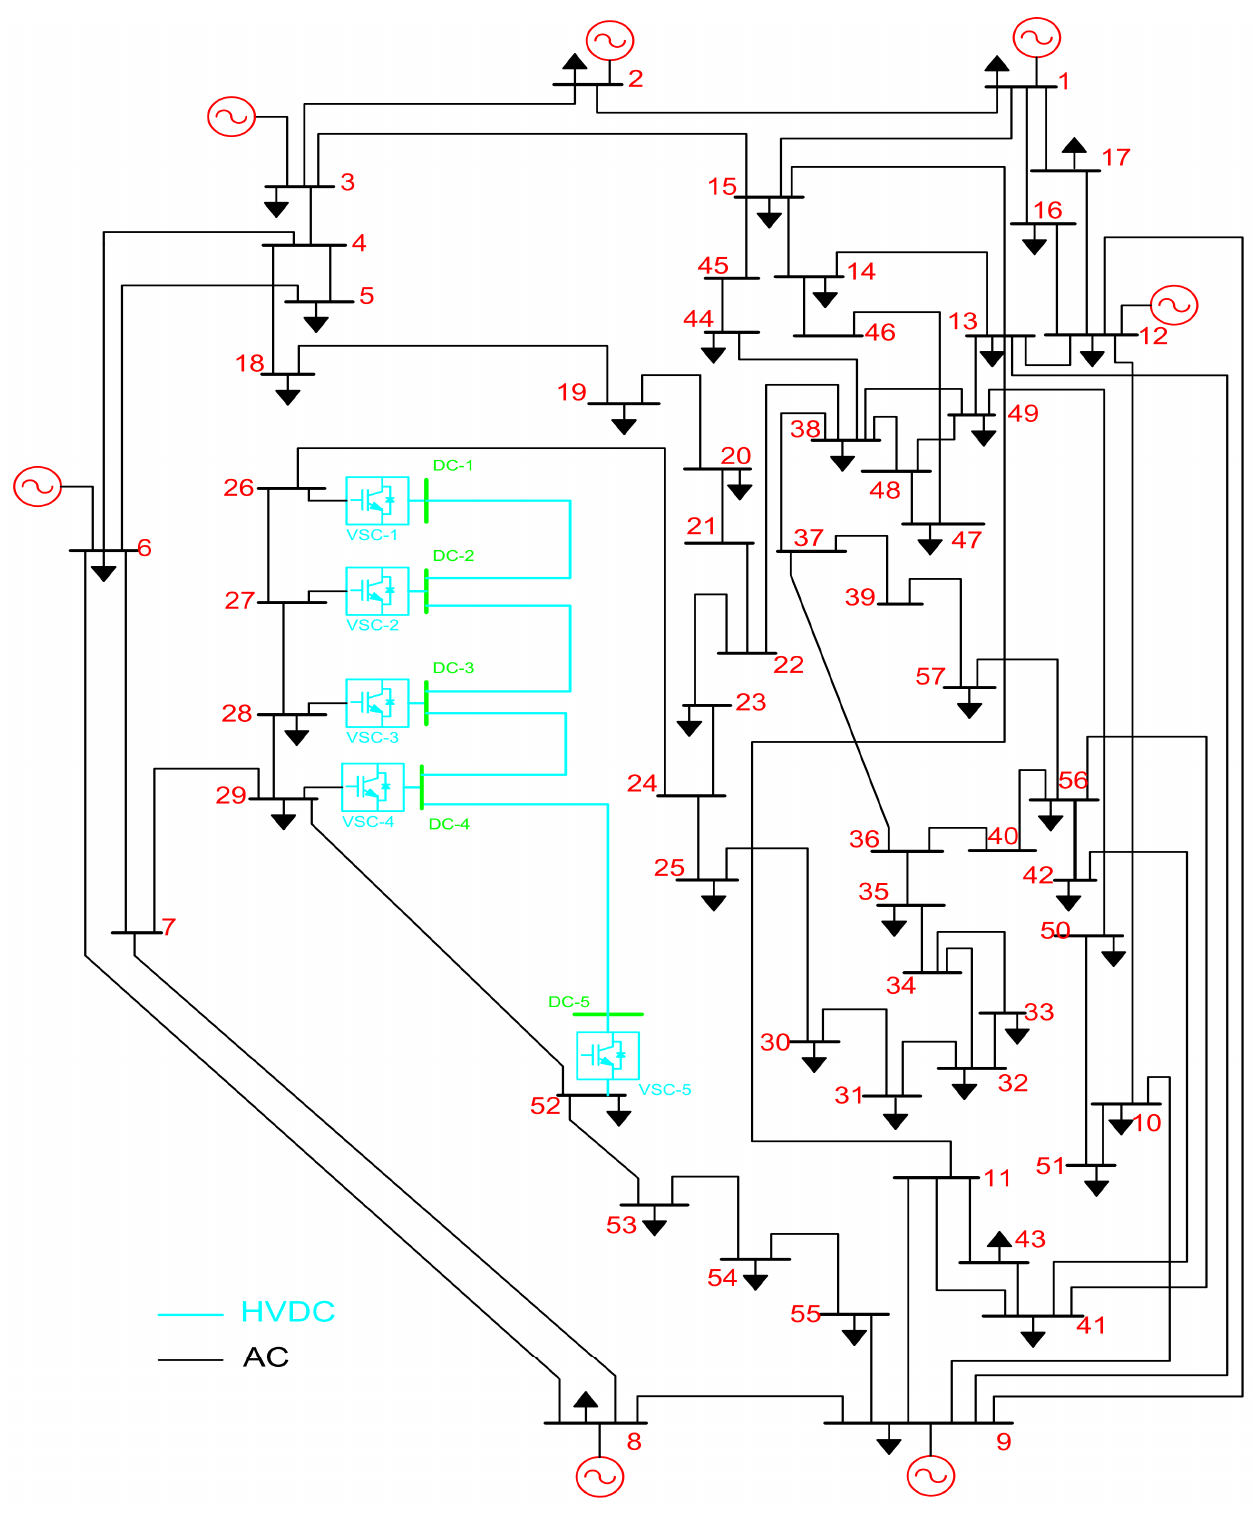
Figure 4. IEEE 57-bus with AC-DC network.